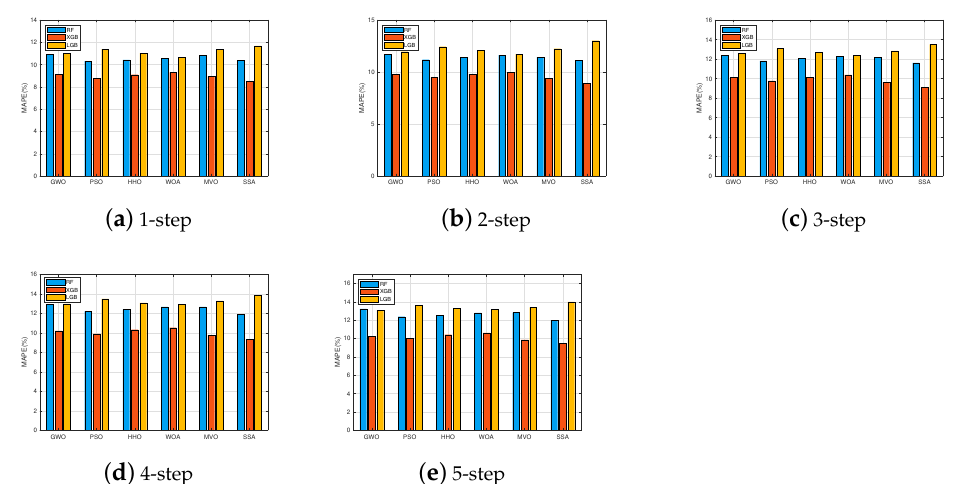
Figure 14. MAPEs of XGBoost, Random Forest and LightGBM with multi-step ahead forecasting steps for the Netherlands